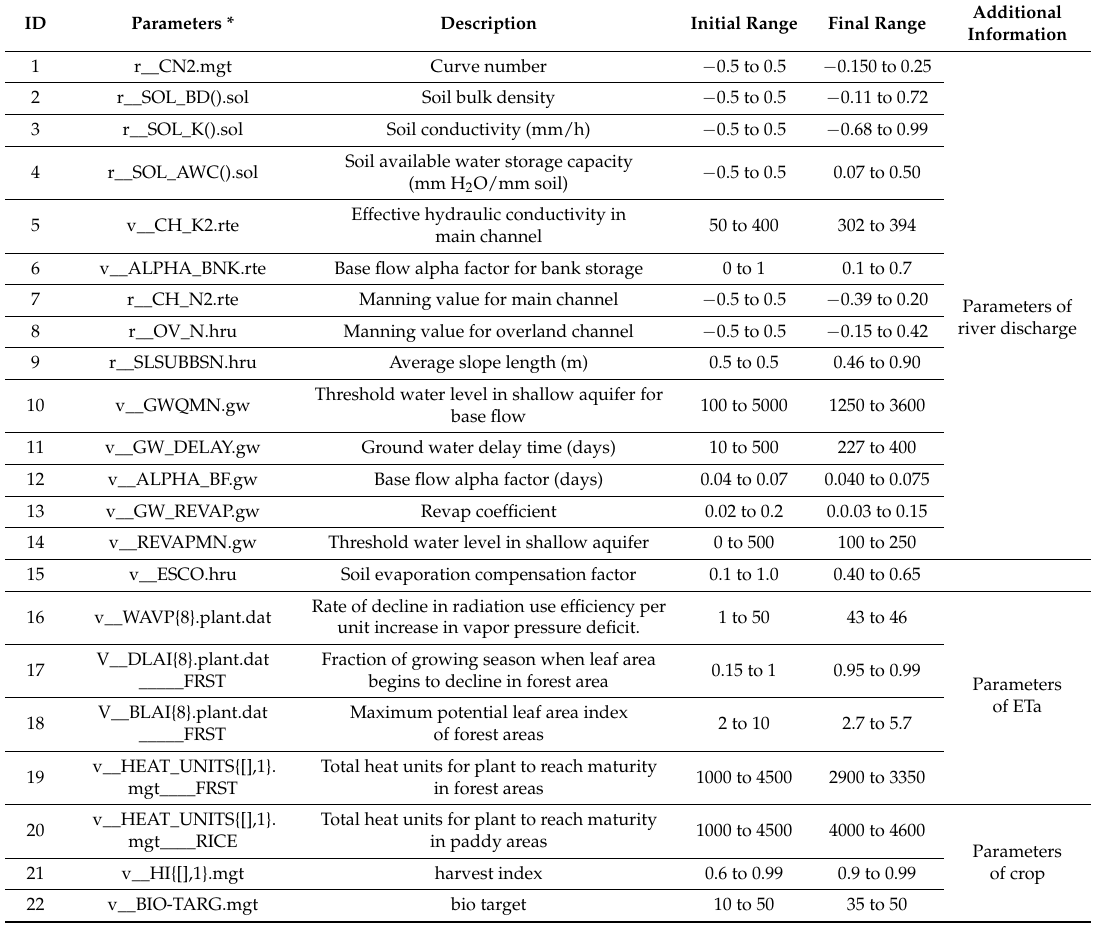
Table 2. Soil and Water Assessment Tools (SWAT) parameters and their initial and final range for river discharge, evapotranpiration (ETa) and crop yield calibration.